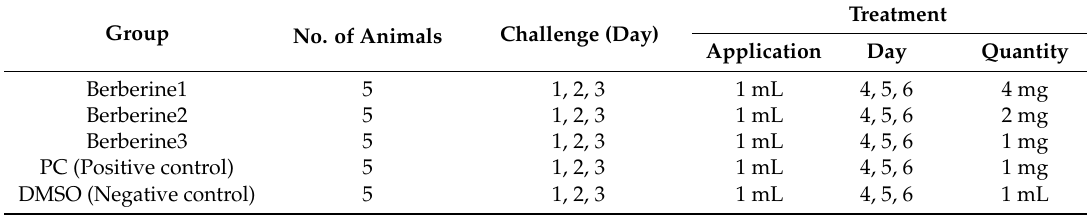
Table 8. Experimental groups of